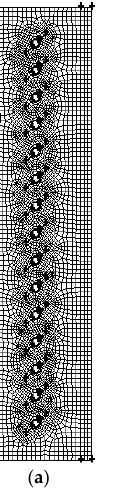
Figure 5. Mesh configurations: ( a ) Pipe-embedded window; and ( b ) Pipe-embedded wall.